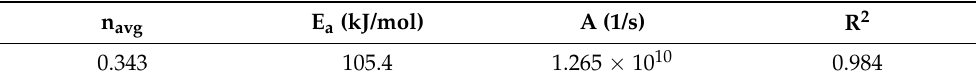
Table 5. Mean time exponent, apparent activation energy, pre-exponential constant and correlation coefficient of the Arrhenius linearization.